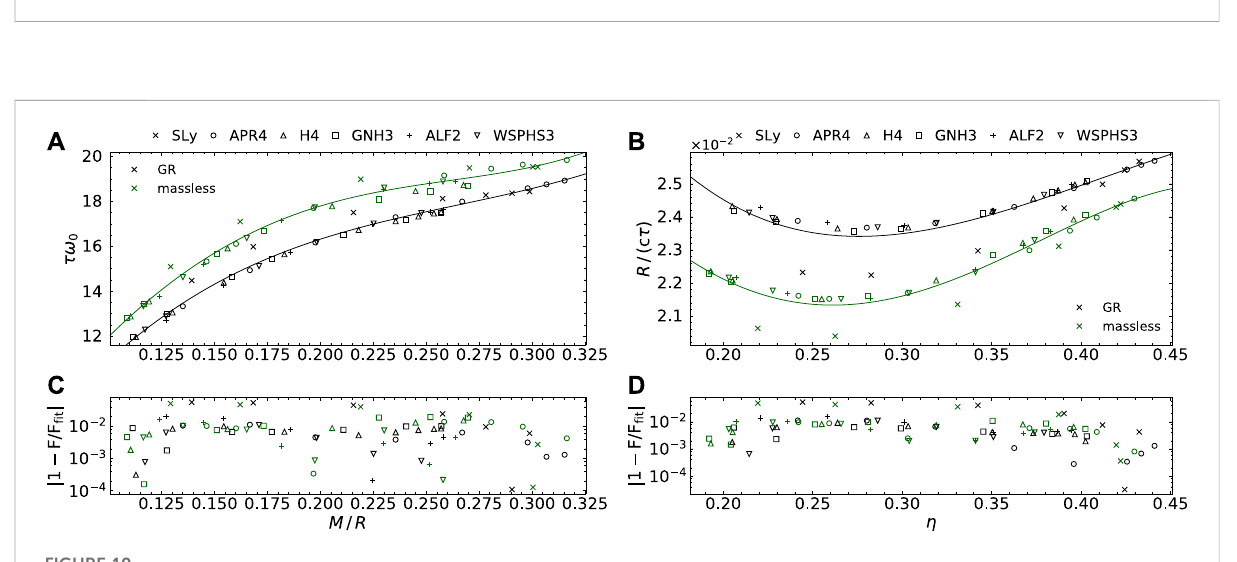
FIGURE 10 Dipole ϕ -mode universal relations: dimensionless damping time τω o versus compactness C = M / R (A) and fi t errors (C) and dimensionless inverse damping time R /( c τ ) versus generalized compactness η (B) and fi t errors (D) . The symbols indicate the respective equation of state, and the color green indicates the massless case, with the general relativistic case in